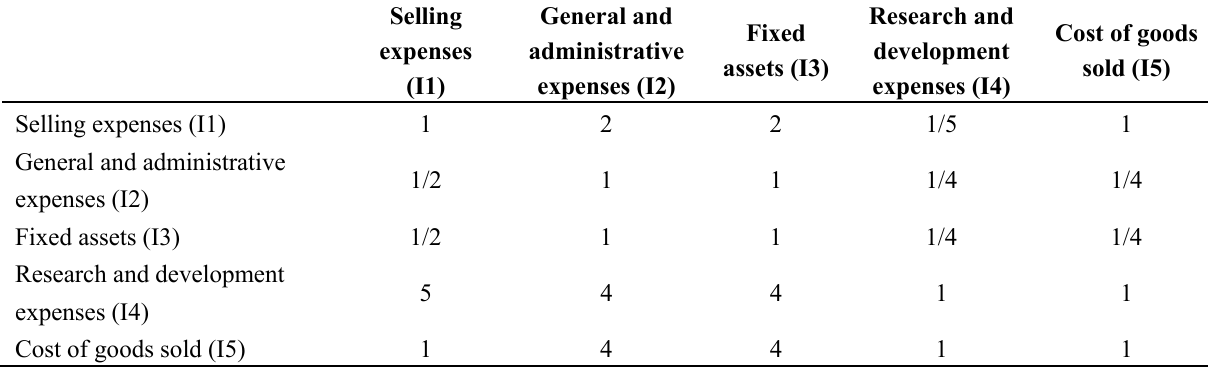
Table 8. Comparison matrix for the inputs by Expert